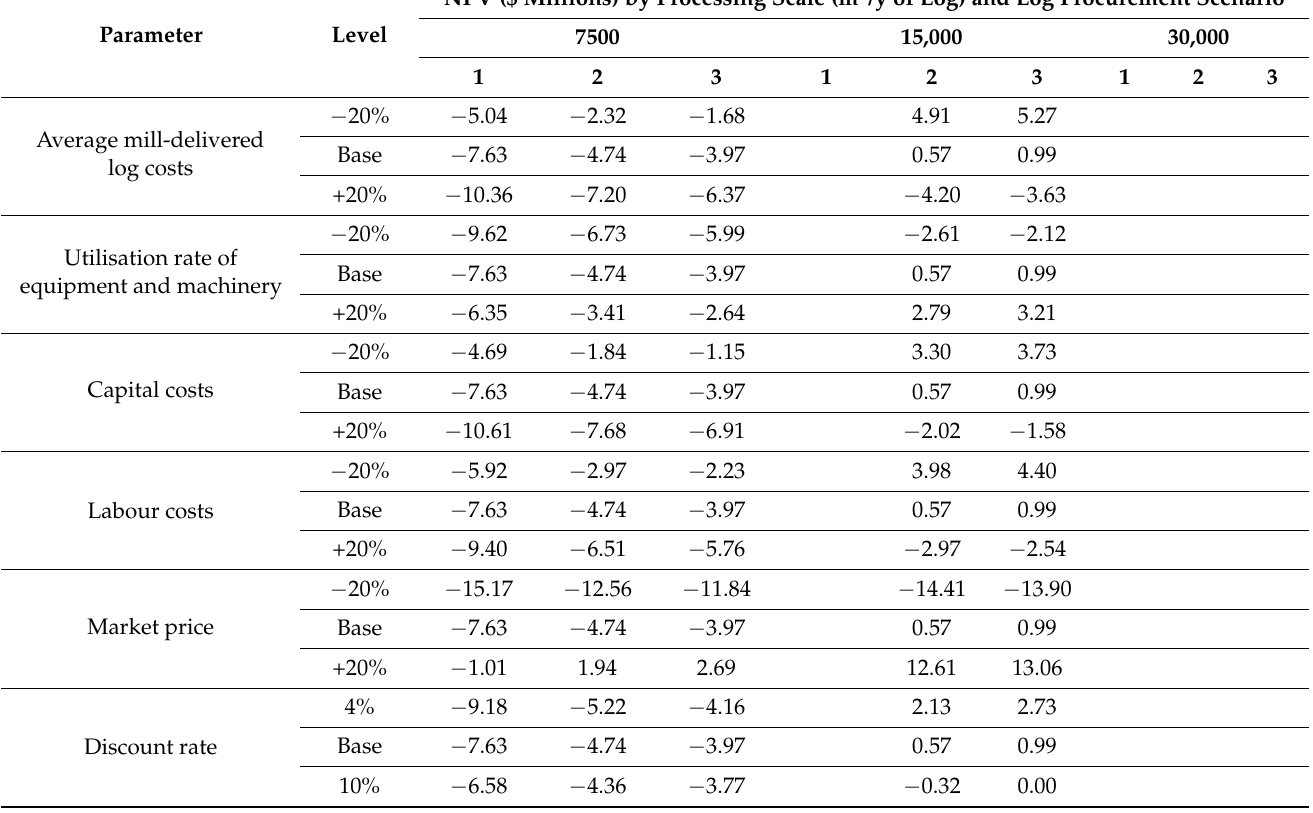
Table A1. Sensitivity of NPV of one-stage LVL manufacture to changes in levels of several important model parameters at facility location A.